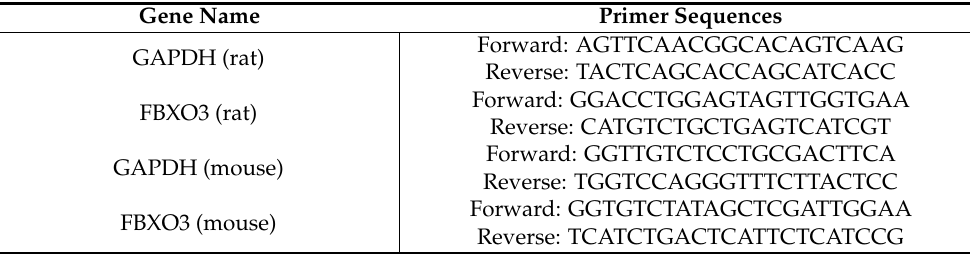
Table 1. Primer sequences for